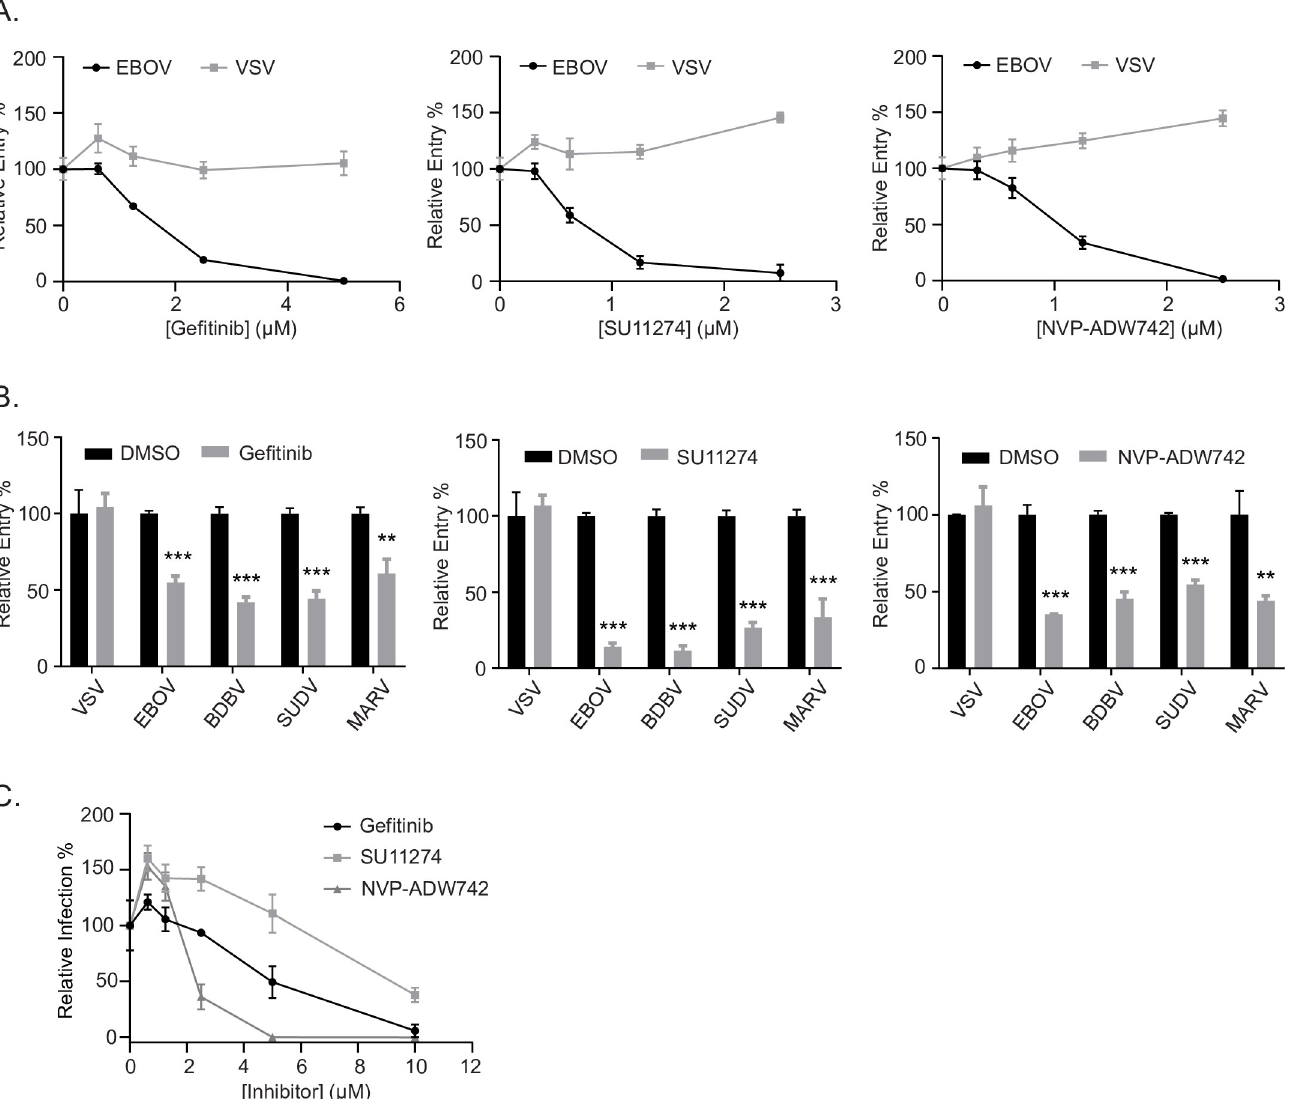
Fig 2. RTK inhibitors block filovirus entry in Vero cells. (A) Entry of β lam VLPs harboring the EBOV GP or VSV G in Vero cells treated with vehicle (DMSO, 0.1%) or increasing concentrations of Gefitinib, SU11274, or NVP-ADW742. Entry was detected via flow cytometry after loading cells with β lam substrate (CCF2) and measuring the percentage of inhibitor treated cells with cleaved CCF2. Data are expressed as percentages relative to DMSO-treated cells. (B) Entry of β lam VLPs bearing the GPs of EBOV, SUDV, BDBV, MARV, or VSV G in the presence of 1 μ M Gefitinib, 1 μ M SU11274, 1 μ M NVP-ADW742, or vehicle (DMSO, 0.1%). (C) Infection of Vero cells with replication-competent EBOV expressing GFP at increasing concentrations of the indicated inhibitor. Infection was measured by GFP fluorescence 3 days post-infection and normalized to vehicle-treated cells. Results are expressed as mean ± s.d. of triplicates and are representative of 3 experiments. � p < 0.05, �� p < 0.01, ��� p <